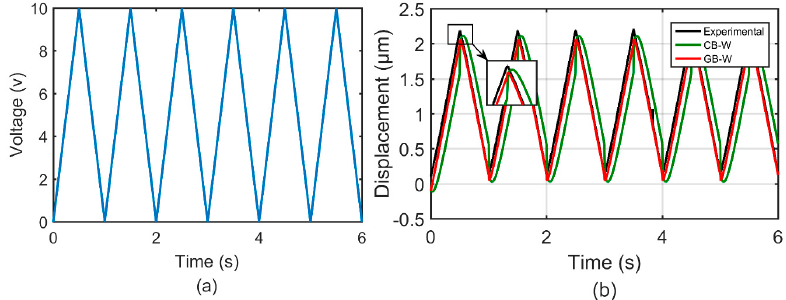
Figure 10. Time histories of: ( a ) A waveform of input excitation signal with the amplitude of 10 and ( b ) the measured and simulation results predicted by the GB–W model and CB–W model.